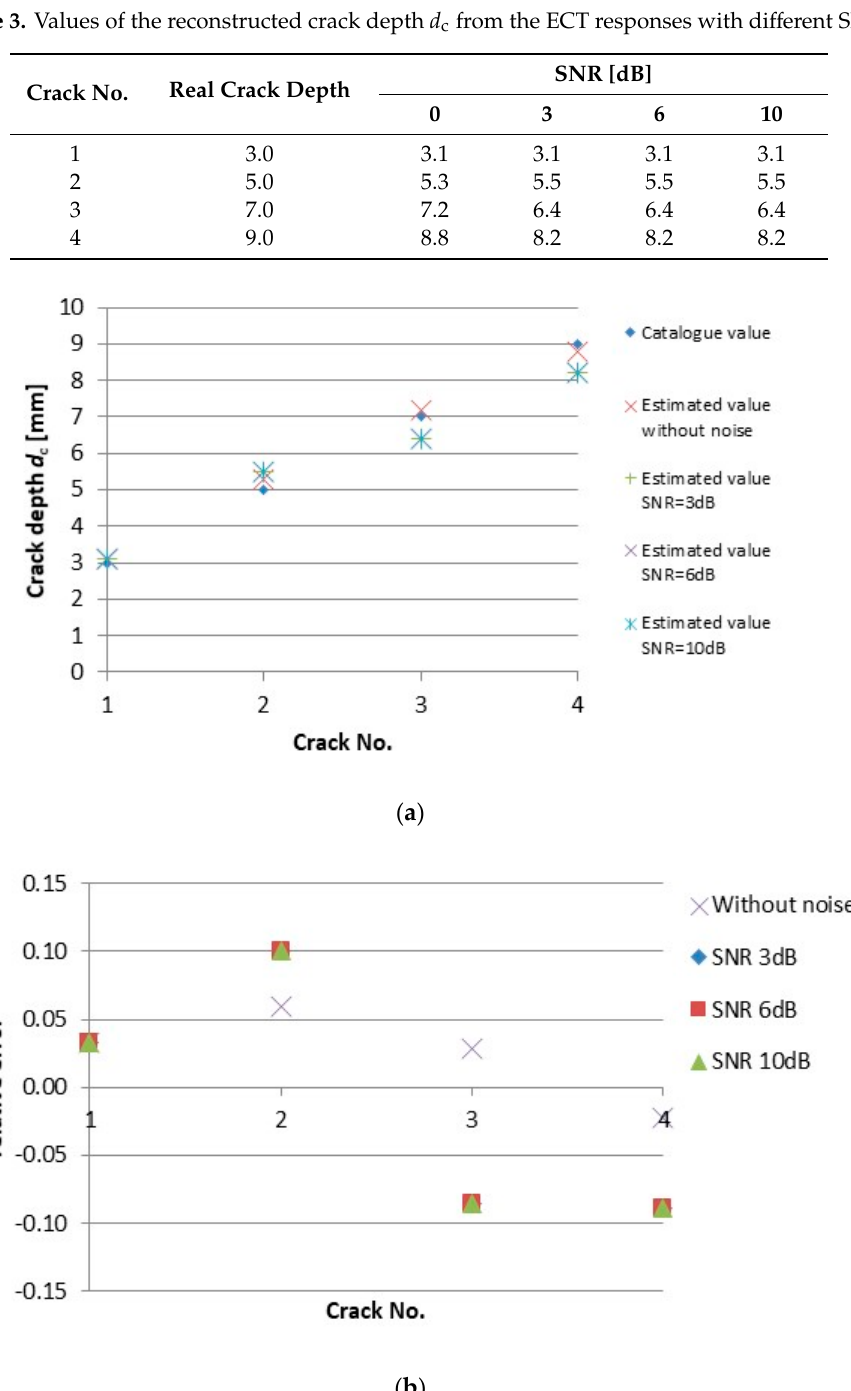
Figure 9. Results of the crack depth d c reconstruction from the ECT responses with different SRN: ( a ) estimated absolute values; ( b ) relative error of estimation.